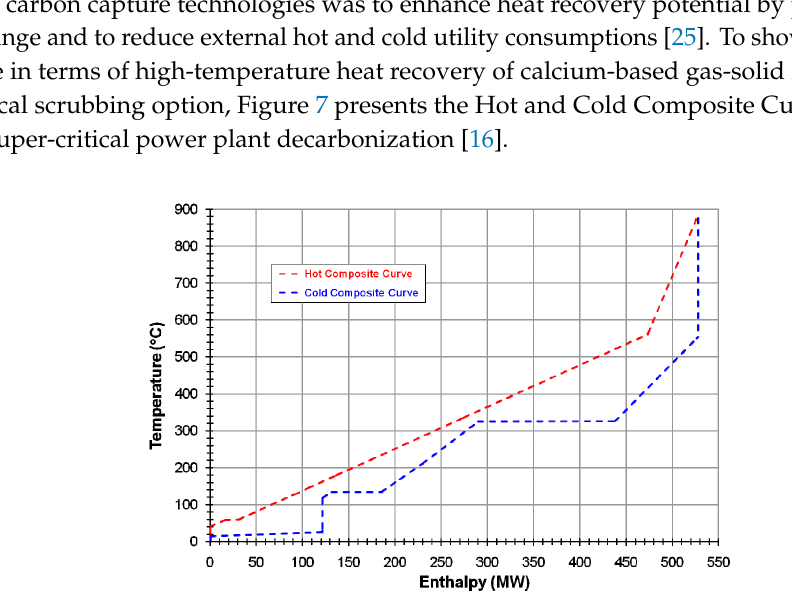
Figure 7. Calcium looping cycle Heat Integration analysis.